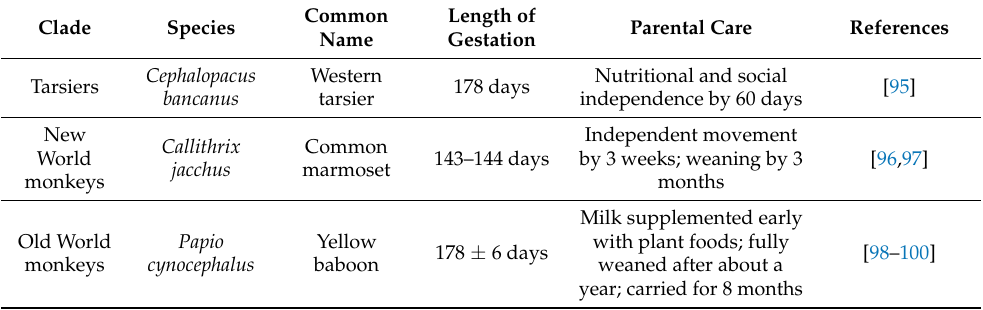
Table 1. Precocity and parental care in selected primates. Apart from tarsier and marmoset, data are from field observations on free-living populations. Gestation lengths are approximate and based on few